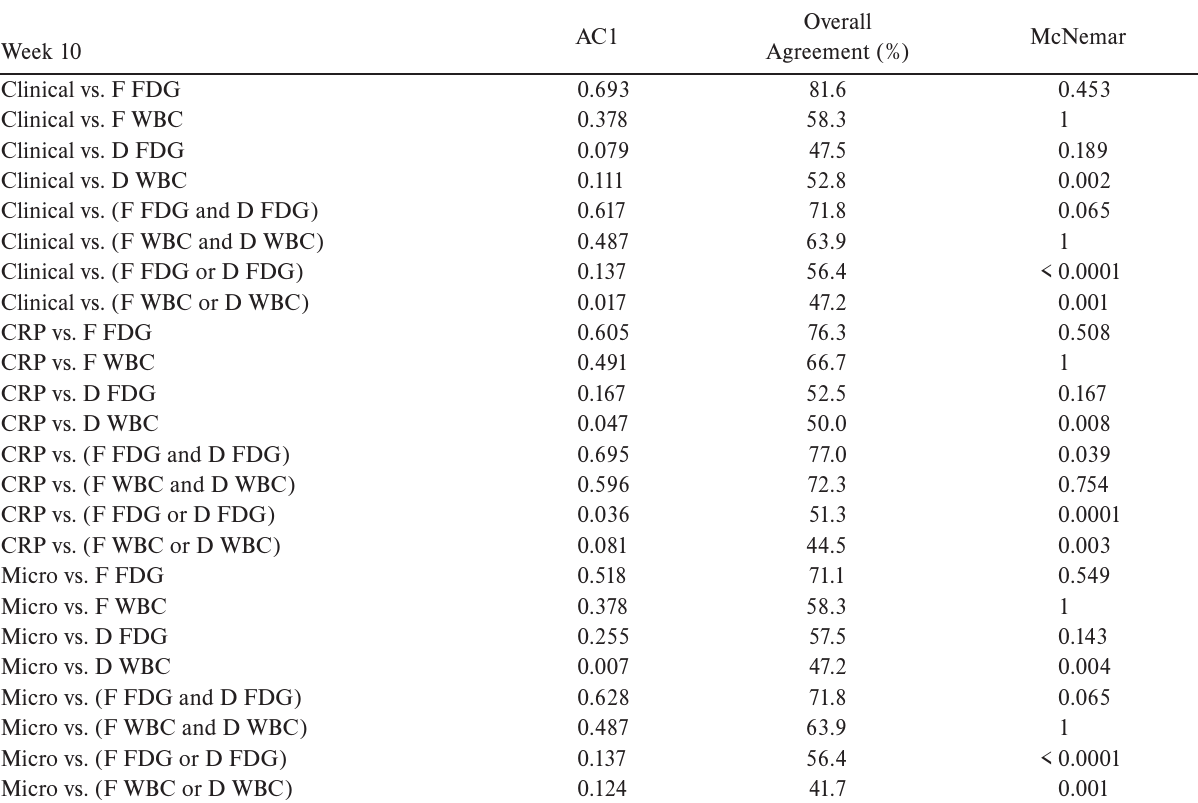
table 2a. Evaluation of agreement between reference parameters and diffuse or focal 18 F-FDG PET/CT and 99m Tc-HMPAO- WBC SPECT/CT findings at 10 weeks after